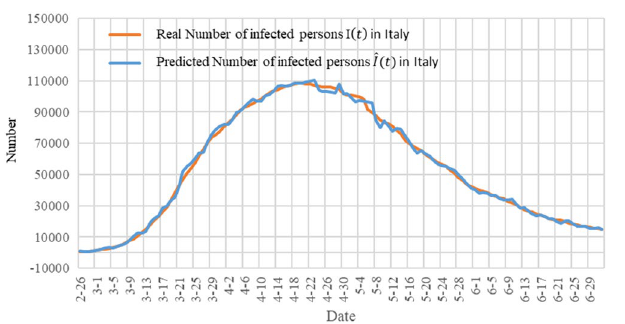
Ex ( t ) of COVID (cid:31)